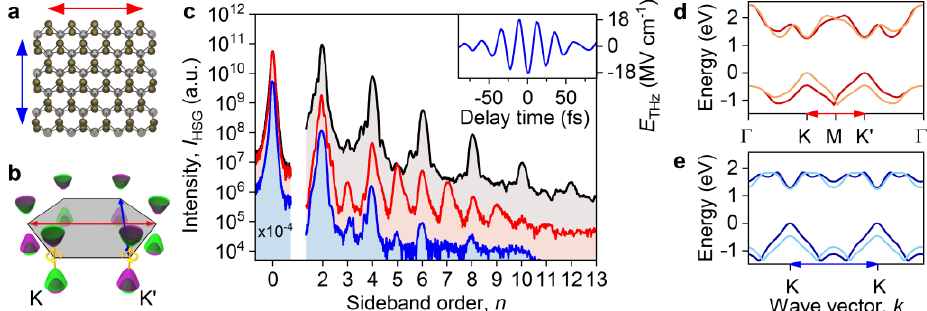
Fig. 1. a Crystal structure of a WSe 2 monolayer (tungsten atoms: grey spheres; selenium atoms: gold spheres). b Hexagonal Brillouin zone showing the spin-split valence and conduction bands at the high- symmetry K and K’ points. c High-order sideband spectra from bulk (black) and monolayer WSe 2 in zigzag (red) and armchair (blue, shifted down by one order of magnitude) direction. Comparable intensities for even and odd orders are observed for the zigzag direction while the armchair direction shows no odd-orders. Inset: Electro-optically detected multi-THz transient. d, e, Band structure of monolayer WSe 2 in the zigzag (red) and armchair (blue) direction as calculated by DFT (dark colors: spin-up; light colors: